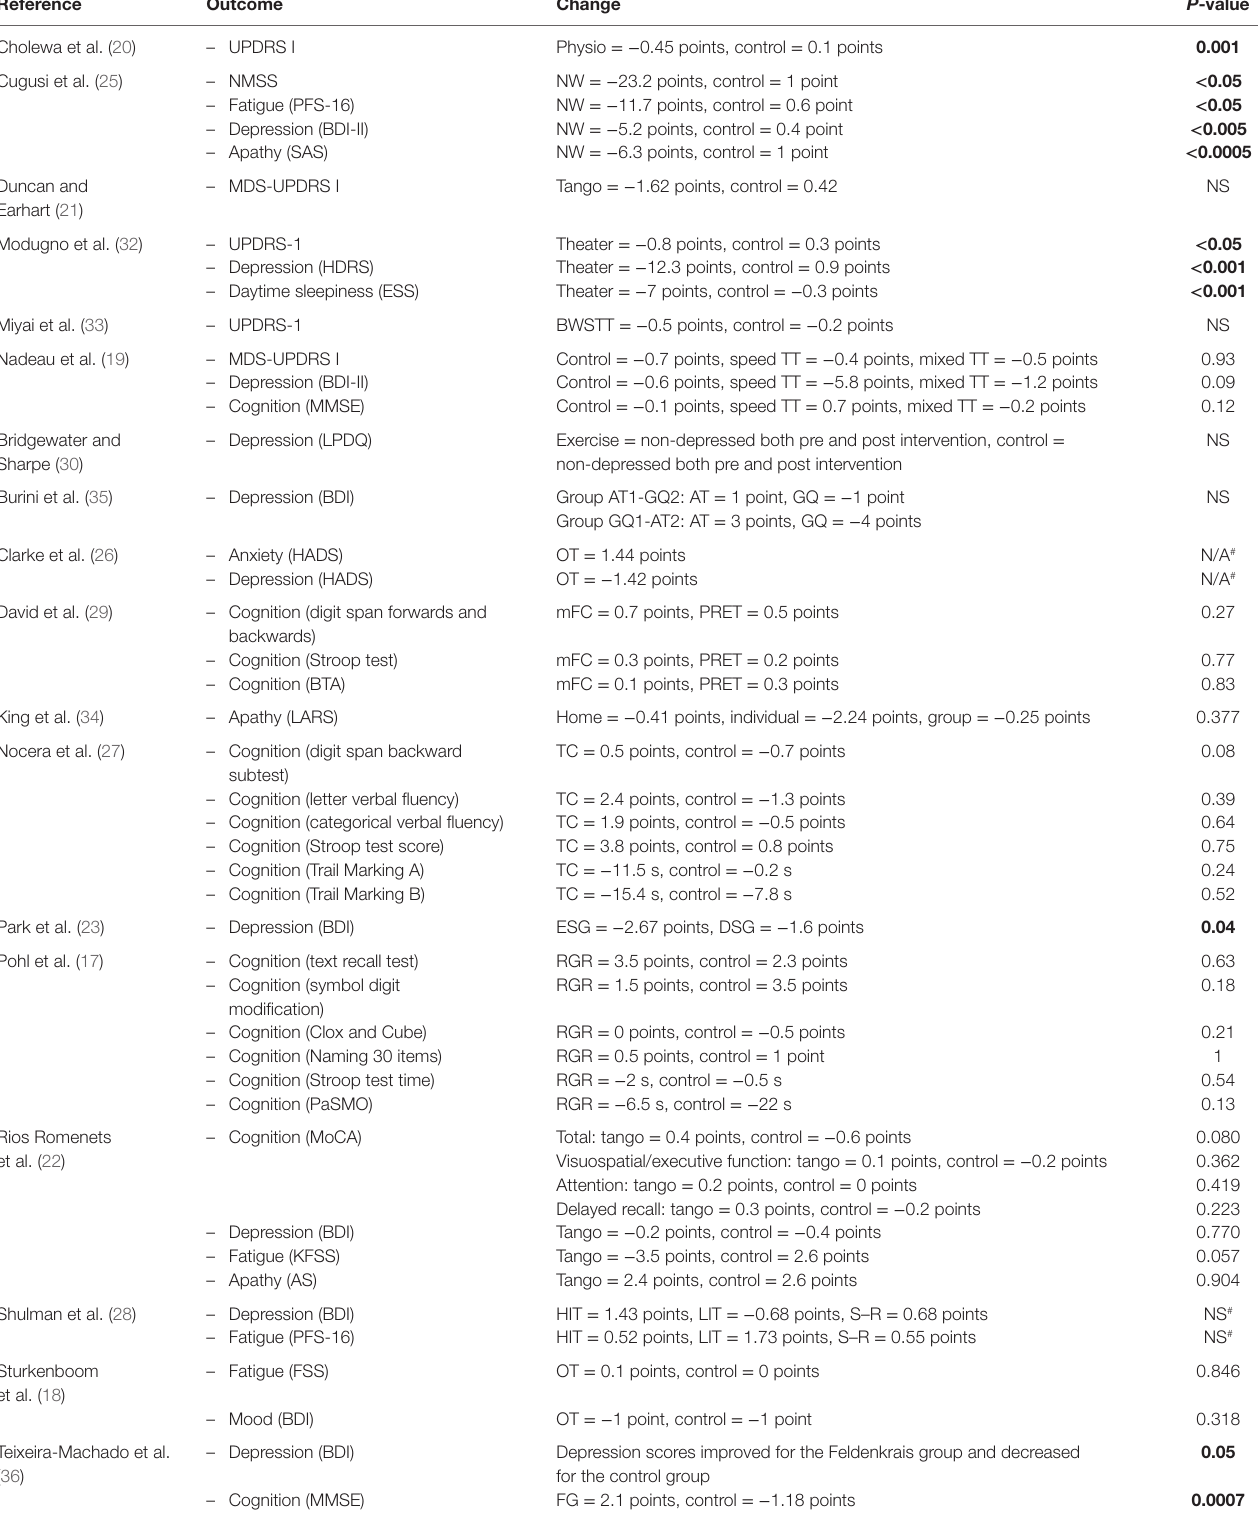
TABLe 2 | non-motor outcomes of